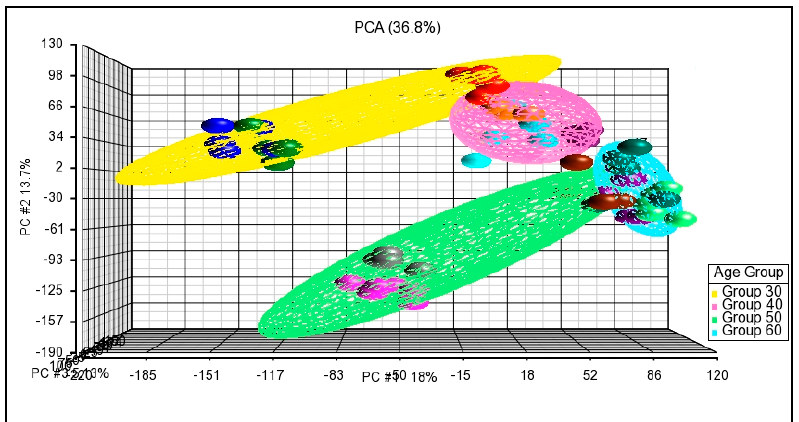
Figure 1. Principal component analysis (PCA) plot; age group 30 (yellow), age group 40 (pink), age group 50 (green), age group 60 (blue). Cells 2021 , 10 , 1611